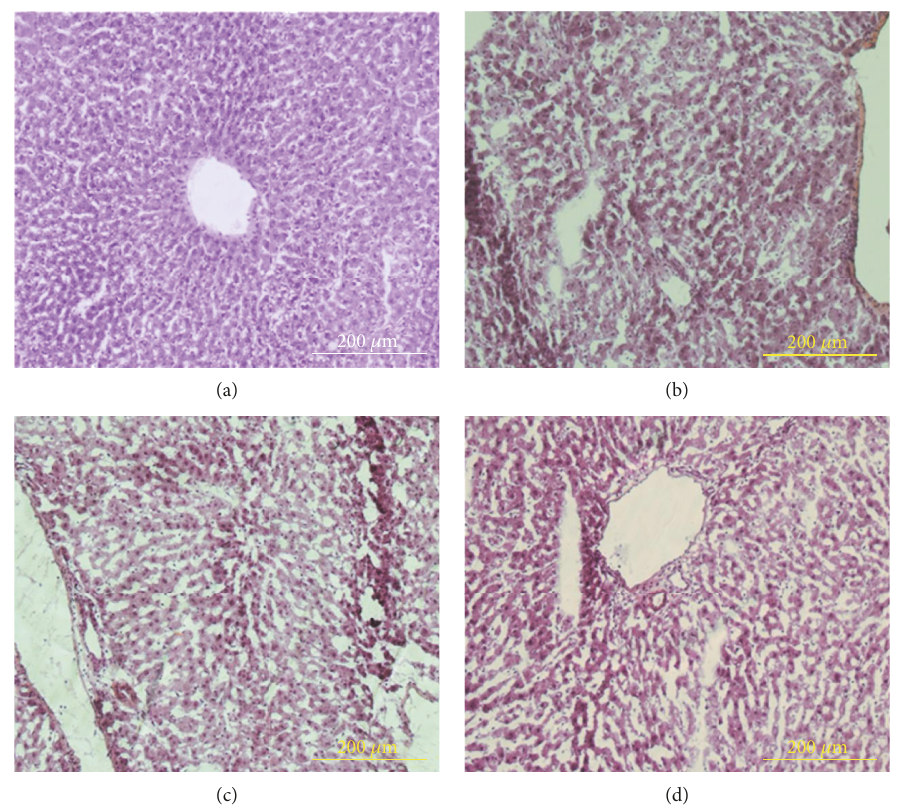
Figure 1: Representative liver tissues stained with hematoxylin and eosin. Normal liver (a), 1-week injection of DMN (b), 2 weeks injection of DNM (c), and 4 weeks injection of DMN (d). Original magni fi cation,